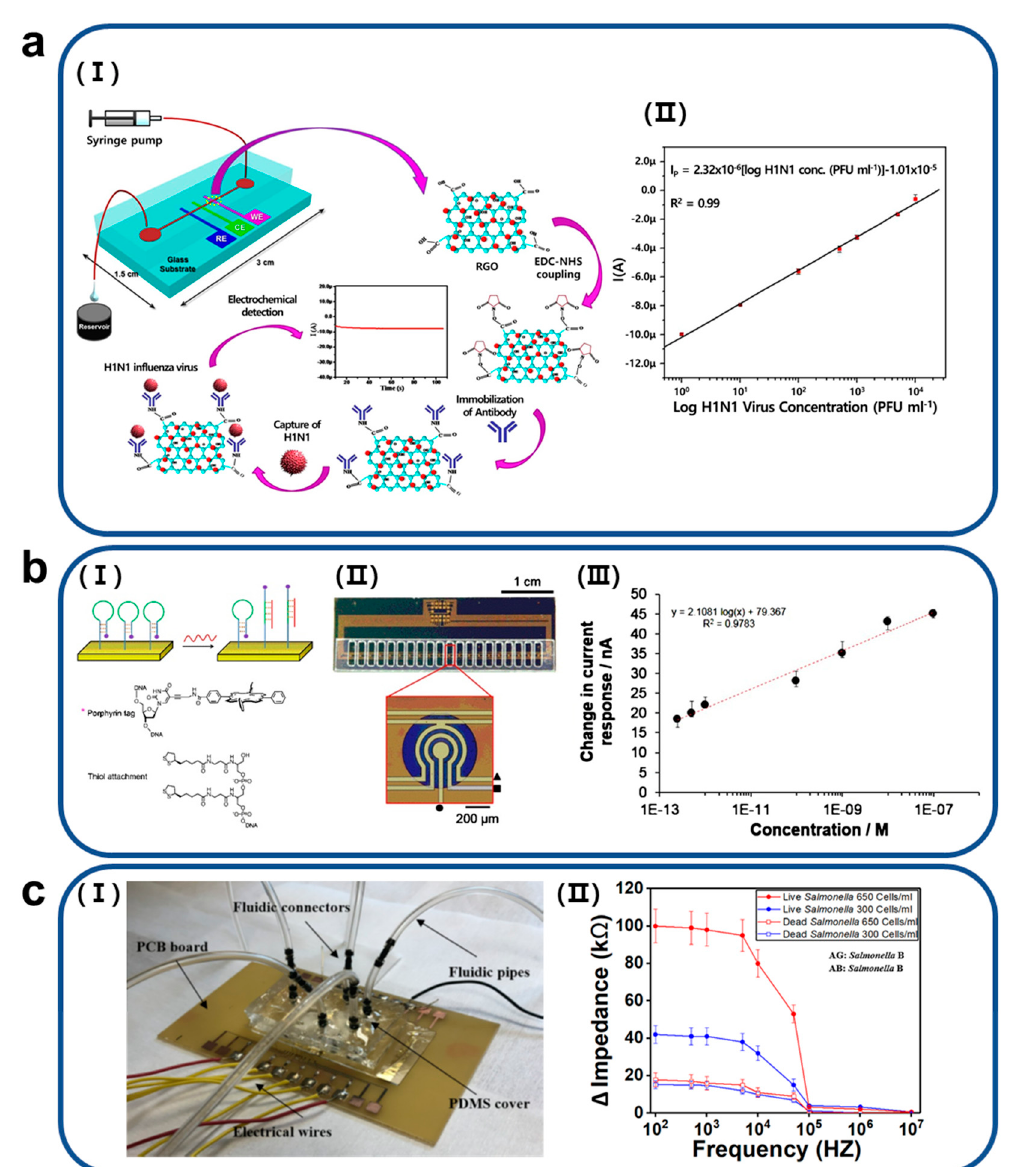
Figure 1. ( a ) (I) A schematic of a microfluidic impedance sensor to detect avian influenza virus H5N1 using microelectrodes coated by reduced graphene oxide (RGO). (II) Calibration plot presenting injected H1N1 virus concentrations (from 1 to 104 PFU mL − 1 ) and the amperometric current through the electrochemical immunosensor with microfluidics. Reproduced with permission from [26] Copyright Scientific Reports 2017. ( b ) (I) A schematic of principle of an implementation of probe (hairpin) DNA to detect a biomarker of bladder cancer and an array of impedance sensing electrodes integrated in a microfluidic bladder cancer biomarker sensing device. (II) A graph of the relationship between biomarker concentrations and electrical current variations. The result indicates that the developed microfluidic impedance sensor allows linear measurements of DNA biomarkers of bladder cancer at concentrations of 100 nM to 200 fM. Reproduced with permission from [31] Copyright Sensors and Actuator B: Chemical 2017. ( c ) (I) A fabricated microfluidic impedance sensor to detect Salmonella from food samples and (II) a result of impedance spectroscopic measurements of live or dead Salmonella at two different concentrations (300 or 600 cells/mL) using the microfluidic impendence sensor. Reproduced with permission from [36]. Copyright PLOS ONE